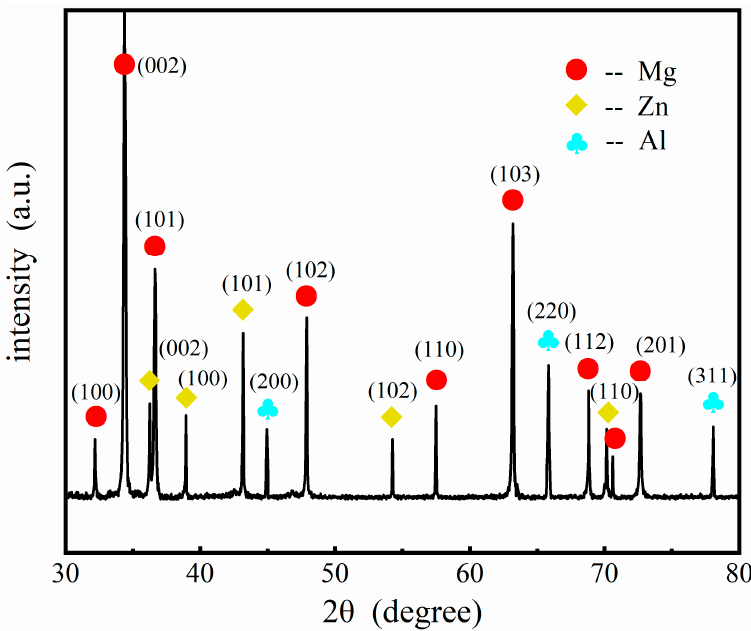
Figure 4. The typical XRD patterns of the electrodeposition Al coatings obtained on the AZ91D Mg